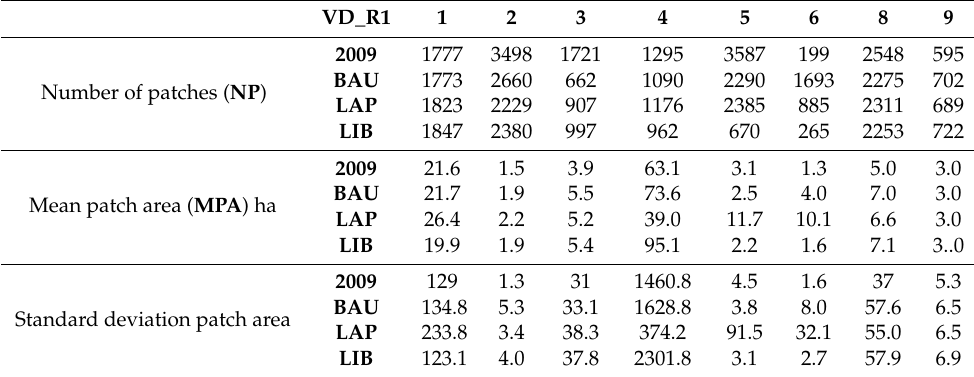
Table 8. Landscape fragmentation parameters for VD_R1: number of patches (NP), mean patch area (MPA) in ha, and standard deviation of the mean patch area, in 2009 and 2050 for each scenario and land use type.